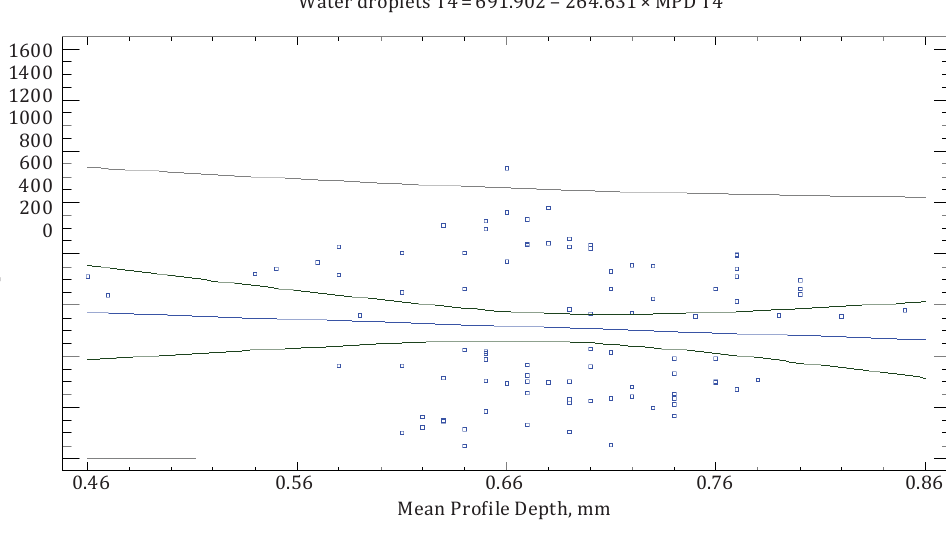
Figure 11. Number of water droplets on Test Track